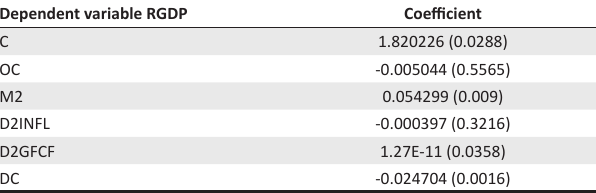
TABLE 5: Model with variables adjusted for